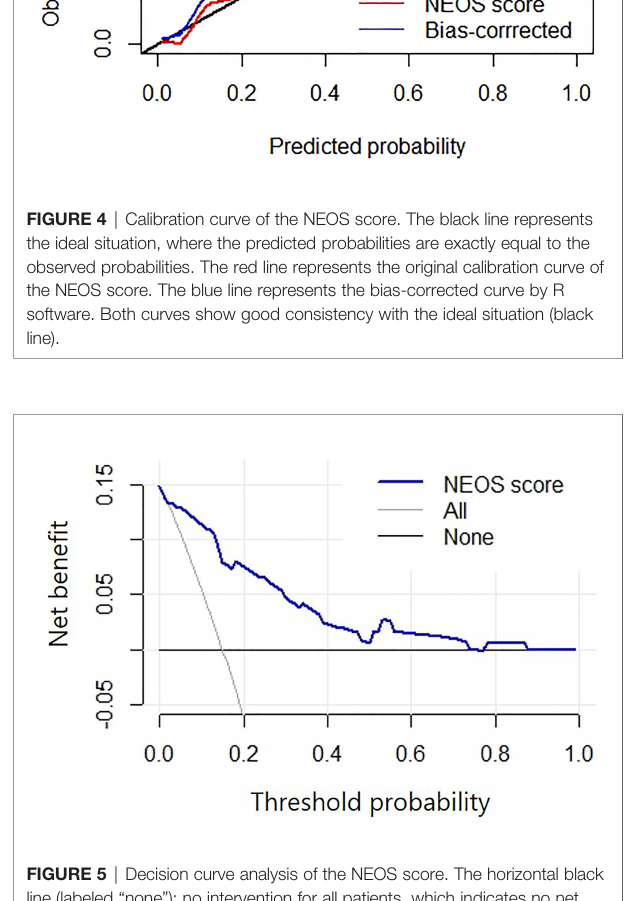
FIGURE 5 | Decision curve analysis of the NEOS score. The horizontal black line (labeled “ none ” ): no intervention for all patients, which indicates no net bene fi ts. The slanted grey line (labeled “ All ” ): all patients accept the intervention. The blue line shows that, compared to intervening with either no or all patients, a greater net bene fi t was achieved by using the NEOS score to predict the one-year outcome when the threshold probability was